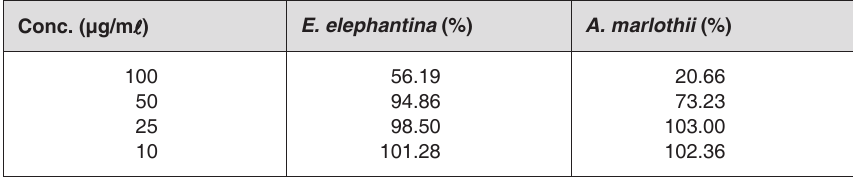
TABLE 1 Percentage parasites for the plant extracts at the serial dilutions Conc. ( μ g/m l )